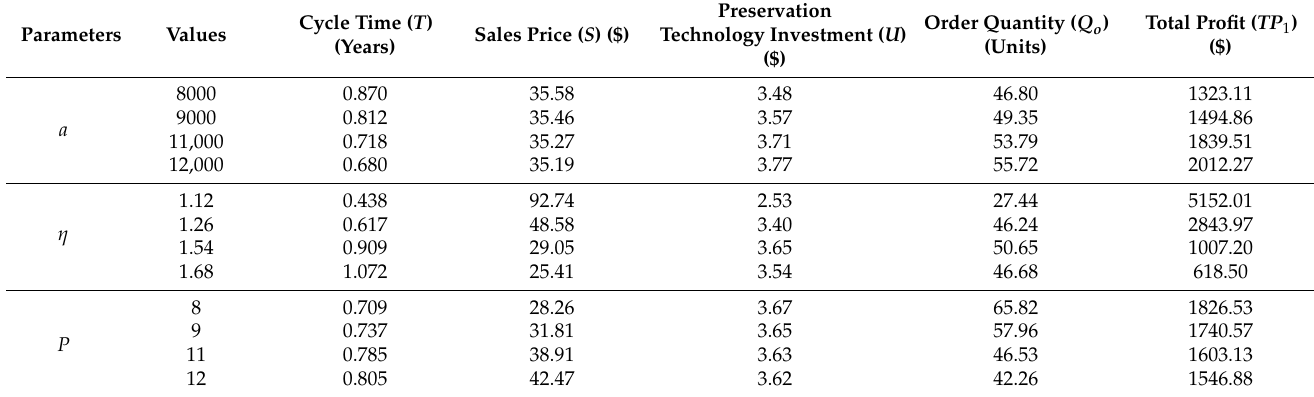
Table 2. Sensitivity